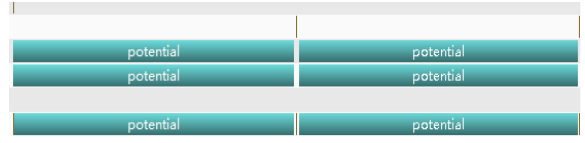
Fig. 3. Performance profile of serial kernels on calculating potentials from NVIDIA Visual